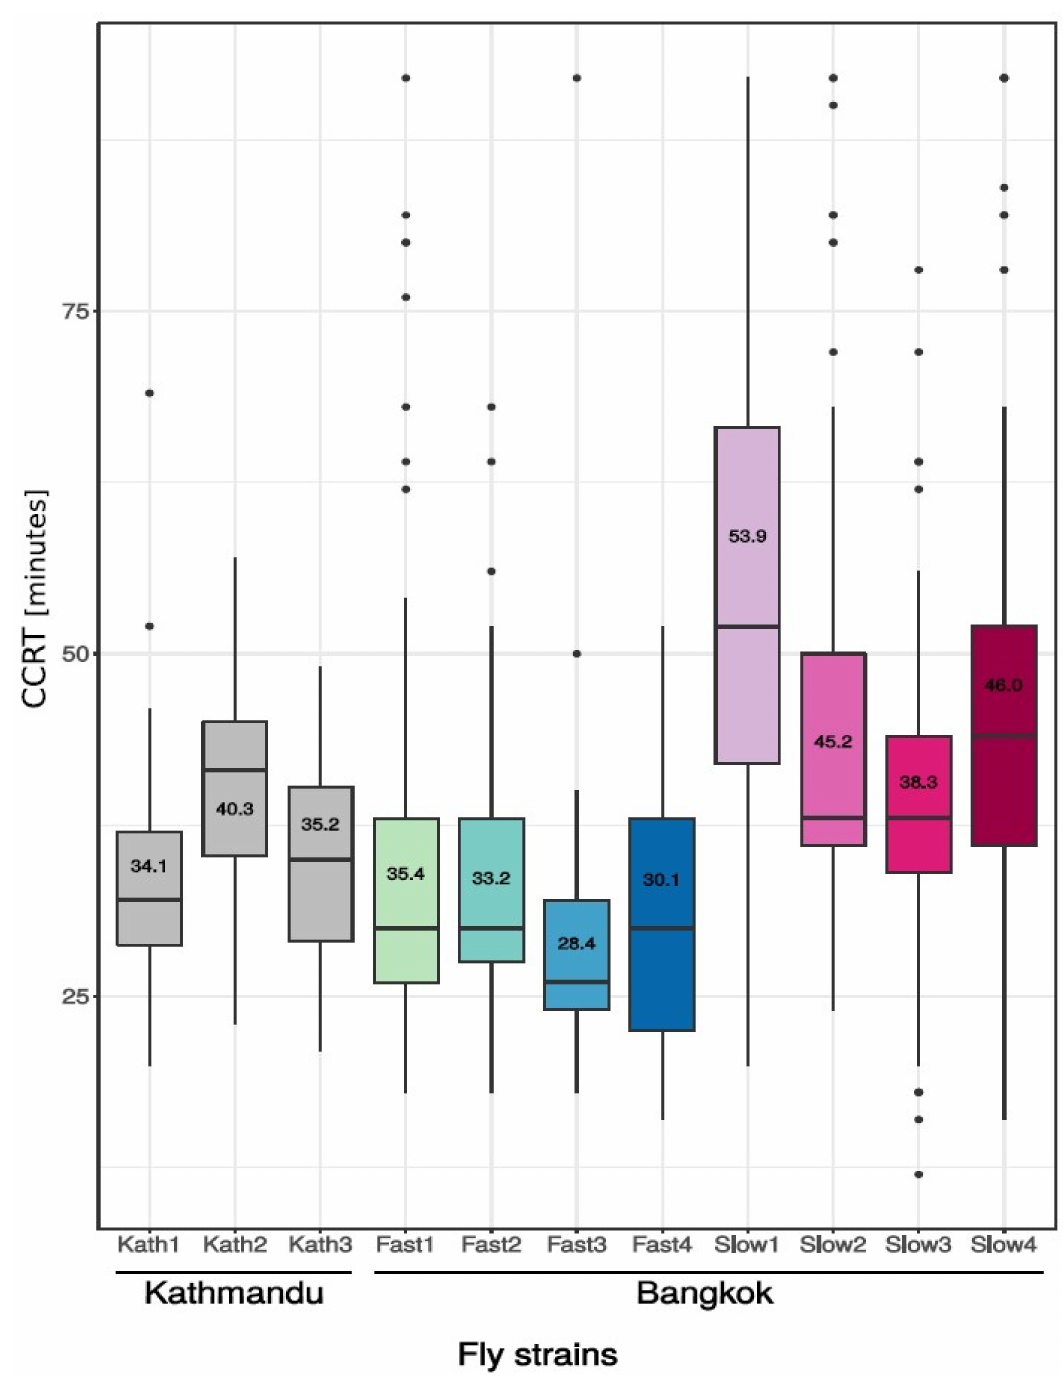
Figure 1. Chill coma recovery time (CCRT) after a cold shock of three hours at 0 ◦ C in four to six-day-old male flies of two populations of Drosophila ananassae : Kathmandu, Nepal (grey) and Bangkok, Thailand (cold-tolerant strains are shown in shades of blue; cold-sensitive strains are shown in shades of red). Data for the individual flies is given in Additional File 3. Y -axis: CCRT in minutes. X -axis: fly